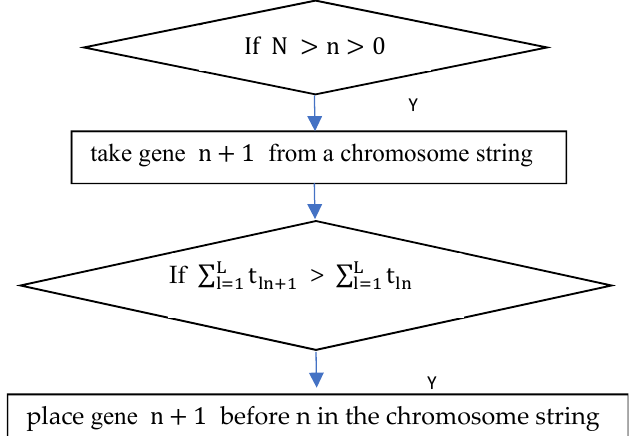
Figure 4. Block diagram of the LPT procedure, where t l,n is the operation time of task n executed on machine l.